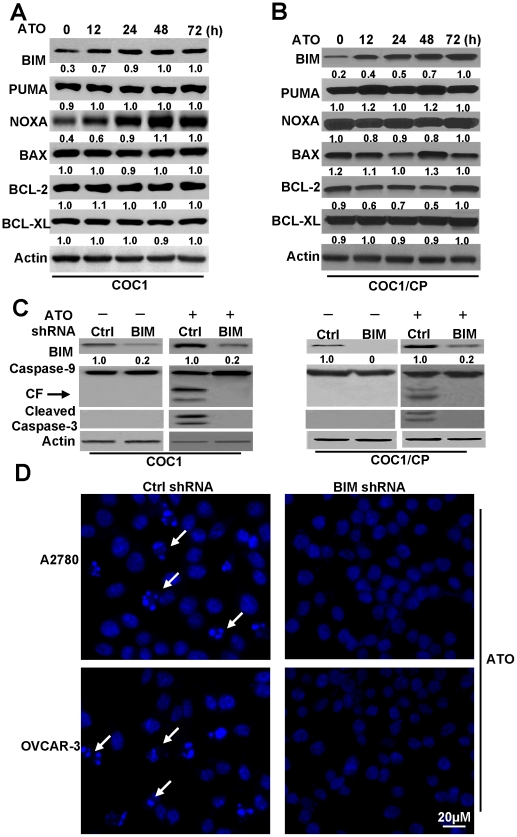
ATO regulated BIM expression is important for cell apoptosis in ovarian cancer cells.
A and B. Western blots analysis of the expression level of BCL-2 family protein. Time-dependent analysis of BCL-2 member's expression levels in COC1/CP and COC1 cells. Cells were treated with ATO (2 µM) at indicated time, then lysed in NP40 buffer for detection. β-Actin was used as a protein loading control. Individual protein levels were measured by densitometric analysis of the Western blots and compared to actin levels. Relative amount of individual protein from treated cells (72 h) was set as 1. C. Effect of BIM shRNA on cell apoptosis. In the same conditions with A, cells were transfected with BIM or Ctrl shRNA for 48 h, and then treated with or without ATO for 48 h. Cell lysates were prepared and assayed for BIM, caspase-9 and cleaved caspase-3 by western blot. CF is referred to cleaved caspase-9. Relative fold means amount of BIM compared to actin and Ctrl condition was regarded as 1. D. Detection the effect of BIM shRNA on cell death with nuclear staining. Cells were transfected with BIM or Ctrl shRNA for 48 h, and then transfected cells were treated with ATO for 48 h. Cell death was assessed by measuring cells with condensed and fragmented nuclear by microscopy. Arrows indicate the condensed, fragmented, brightly stained nuclei, which are the hallmark of apoptosis. All data are representative of three independent experiments.